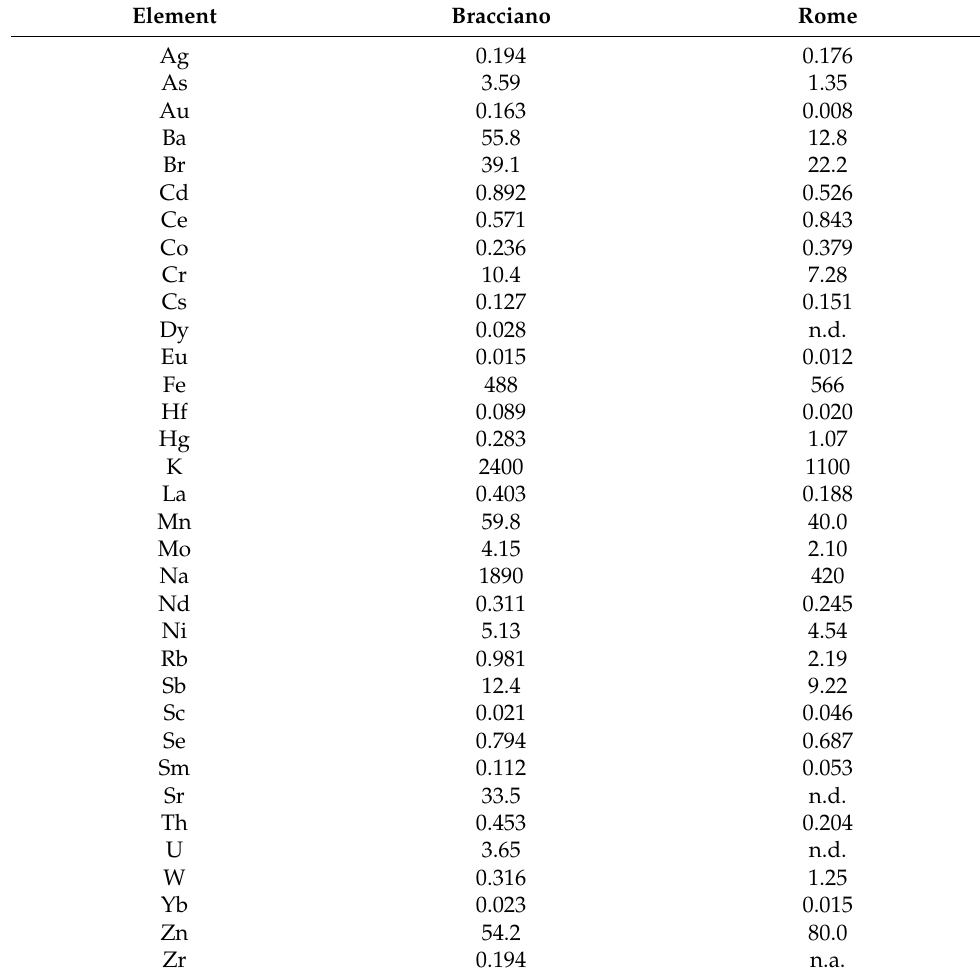
Table 8. Element concentration level (ng m − 3 ) in PM 10 filter sampled during the study and compared with Rome’s levels reported in [48]. Element Bracciano Rome Ag 0.194 0.176 As 3.59 1.35